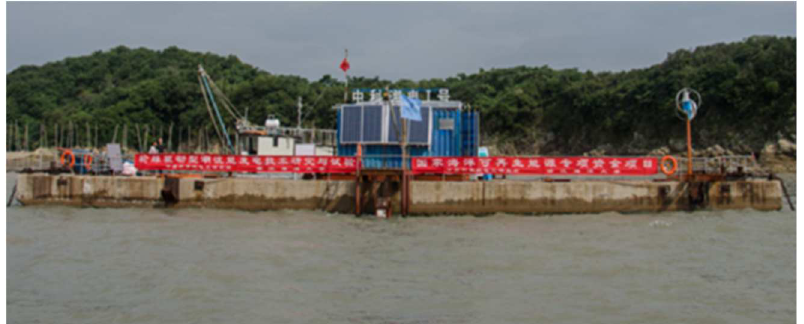
Figure 2. “Zhongke Hydropower No. 1” tidal power generation platform. On spring tide days, the platform records the more typical daily tidal energy gener- ation data obtained, as shown in Figure 3.